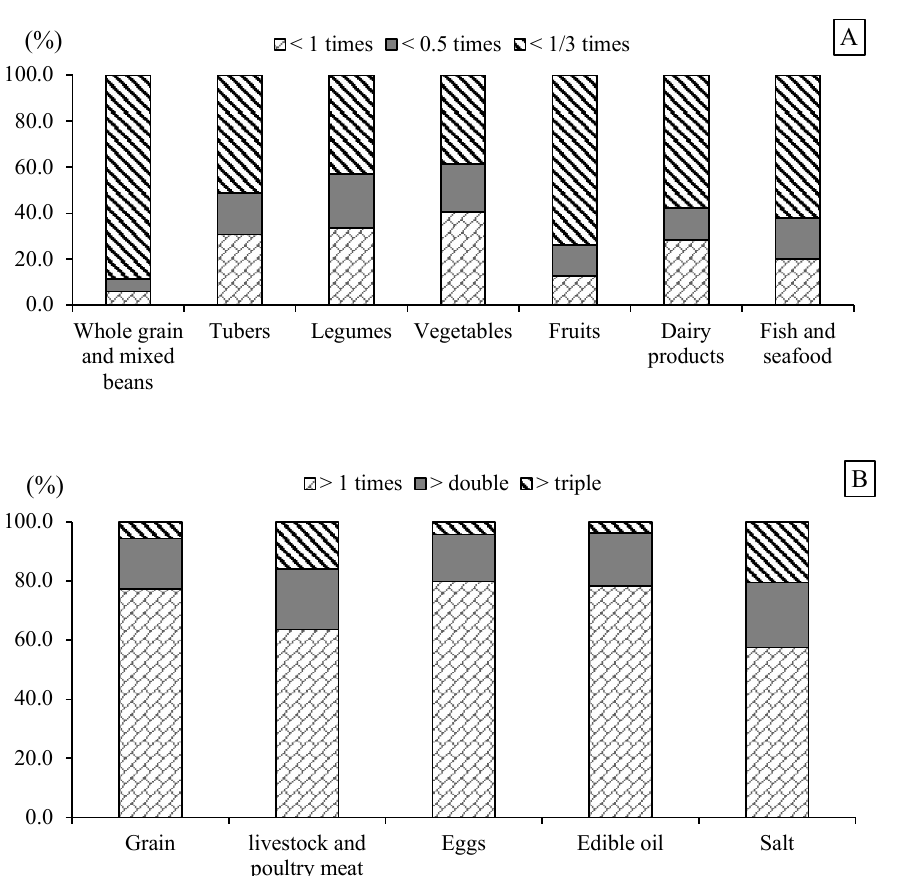
Figure 2. Distributions of insufficient ( A ) or excessive ( B ) intake of major foods among Chinese adults aged 55 years and above in four provinces in 2020.